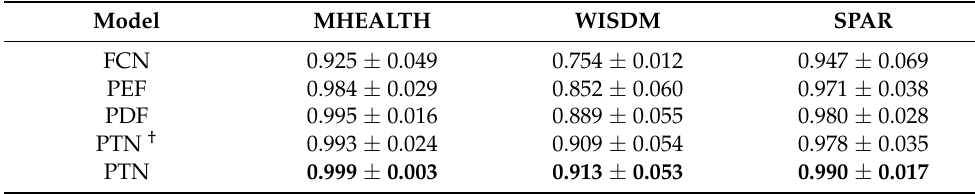
Table 2. Activity classification performance 1